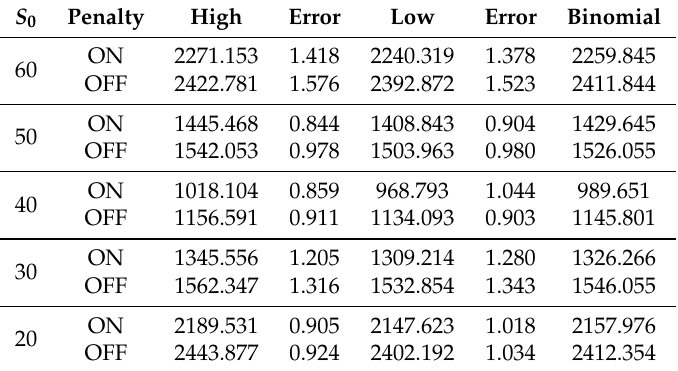
Table 2. Swing option values as a function of initial asset price and usage penalty with a single underlying asset. Parameter values used are N u = N d = 2, U i = { 20,40,60 } , b = 20, R = 4000, m = 5, U min = − 90, and U max = 90. S 0 Penalty High Error Low